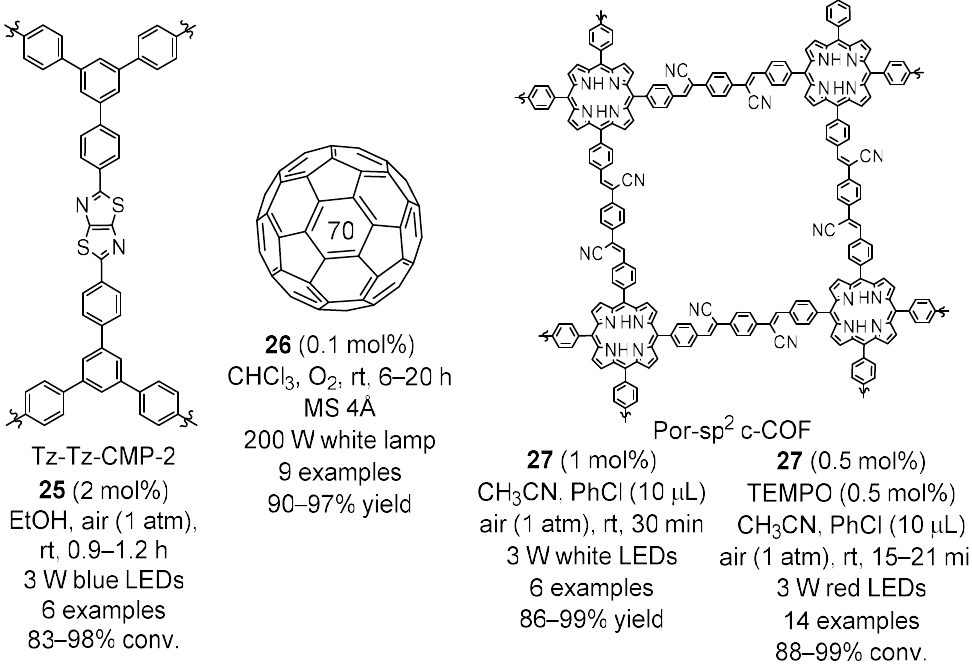
Figure 2. Results obtained in the aerobic oxidative dehydrogenation of secondary amines to imines 24 catalyzed by 25 – 27 .